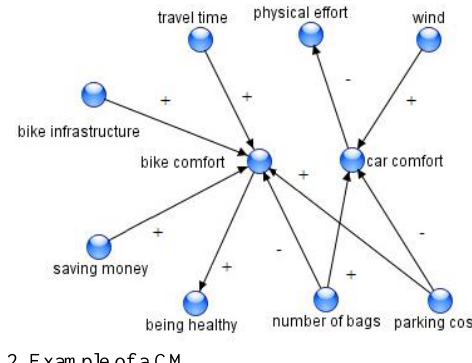
Fig . 2. Example of a